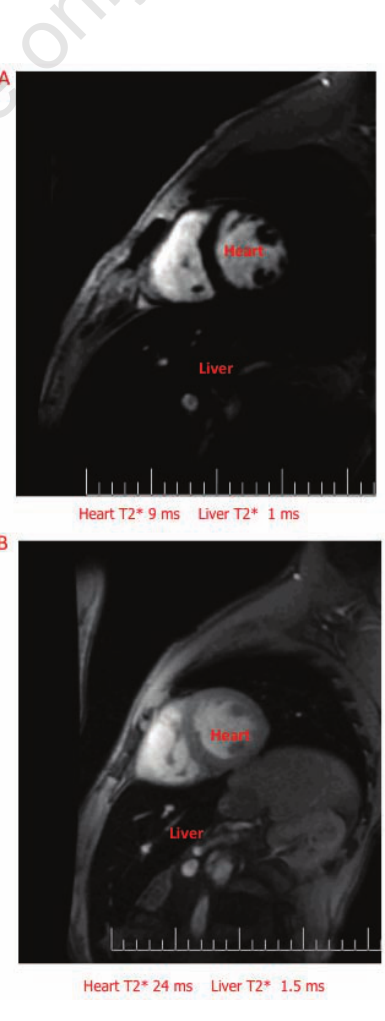
Figure 6. Cardiac MRI in patients with thalassemia major. A. Severe liver and heart iron. B. Severe liver iron and normal heart iron (courtesy of Dr. G.